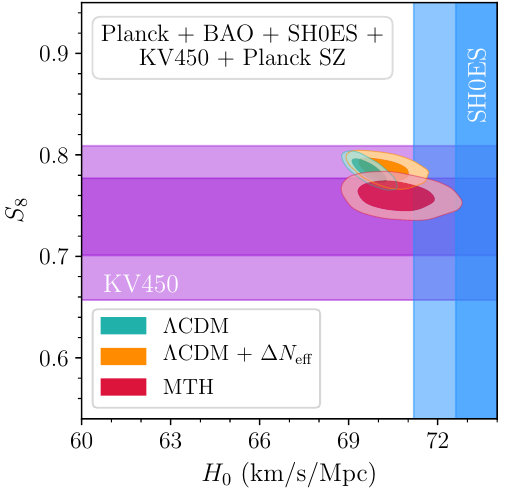
Figure 14. Same as figure 13(b) but now including the Planck SZ data. We include non-linear corrections to the MTH fit from HMcode and Halofit in figure